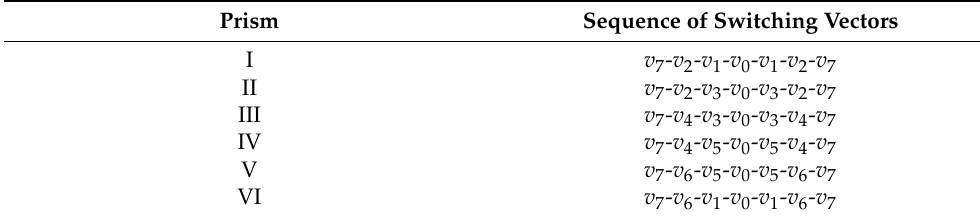
Table 3. Sequence of switching vectors in each prism. Prism